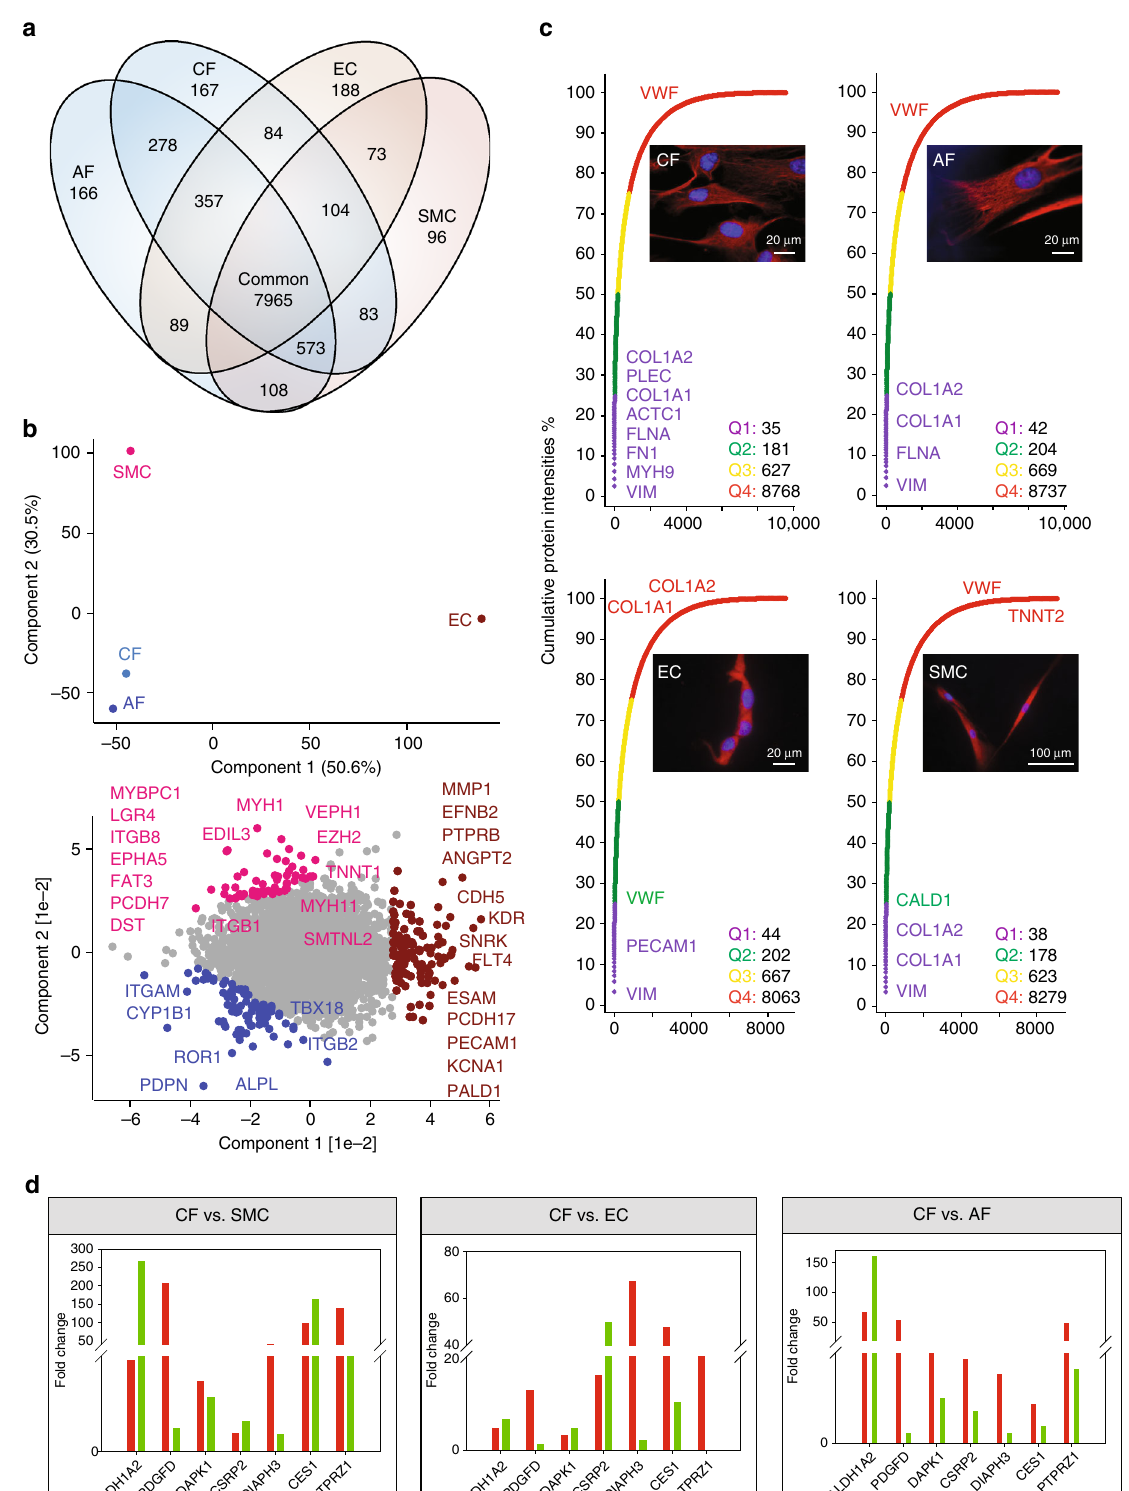
Fig. 5 Comparative analysis of the cell-type proteomes. a Commonly and exclusively quanti fi ed proteins in three cardiac cell types and adipose fi broblasts. b PCA comparing the four cell types based on component 1 and 2, which accounted for 50.6 and 30.5% of the variability, respectively. c Cumulative protein abundances for each cell type and total number of proteins constituting the quantiles (Q1 – Q4). The corresponding cell types are illustrated with immuno fl uorescence pictures at ×100 magni fi cation. d RT-qPCR (green) and proteomic (red) fold-changes of the indicated genes in CF compared to all other cell